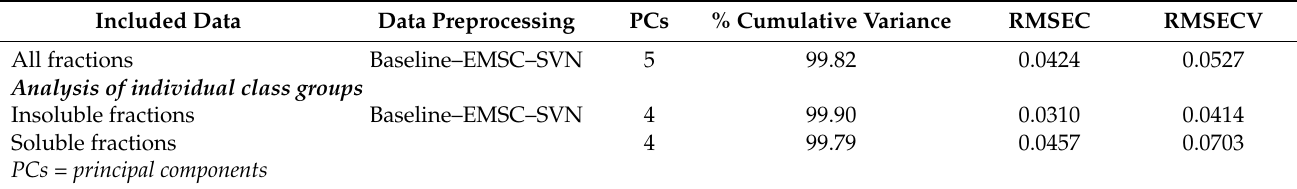
Table 3. Summary of the PCA results in all fractions and in separated